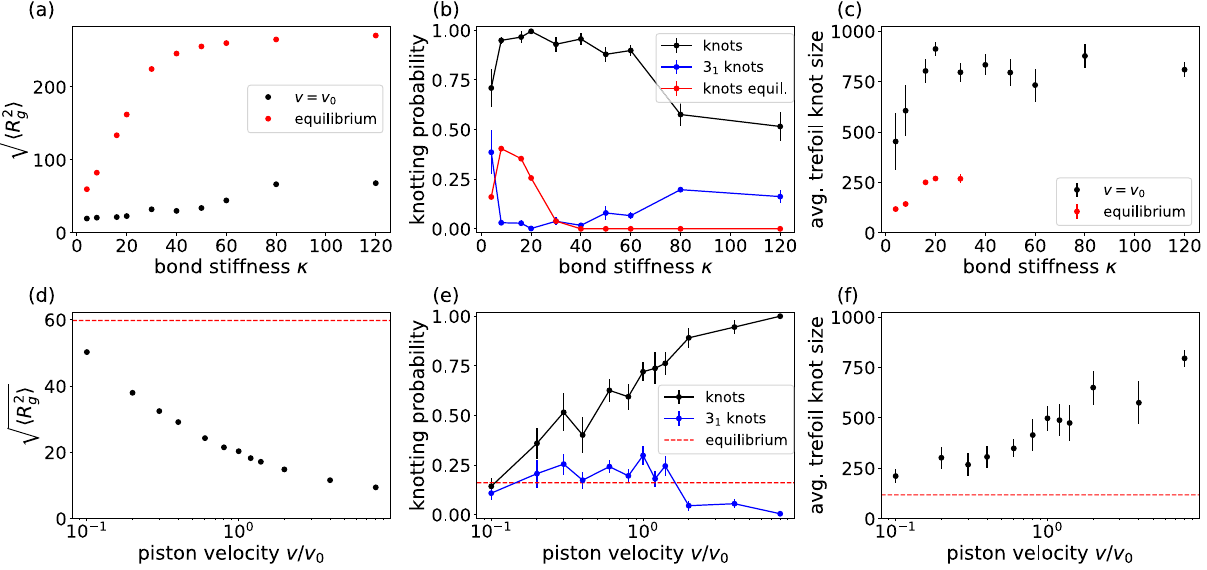
Figure 1. Knots and radii of gyration of steady-state configurations for different input parameters. ( a ) Root- mean-squared radius of gyration (cid:31) (cid:31) R 2 g ( t ) (cid:30) for chains of different stiffness. Error bars are omitted as their size is smaller than the size of the points. ( b ) Knotting probability and occurrence probability of trefoil knots for different values of the bond stiffness κ . Error bars are determined by taking the standard deviation over the square-root of the number of runs. Lines are added for readability. Knotting probability for v = 0 is strictly zero for κ ≥ 50 . ( c ) Trefoil knot lengths found for different κ with a moving piston and in equilibrium. ( d ) (cid:31) (cid:31) R 2 g ( t ) (cid:30) for different piston velocities at κ = 4 . Again the size of error bars would be smaller than the size of the points. The red dashes in ( d – f ) indicate the average result in MC simulations without a moving piston for κ = 4 which is equivalent to the leftmost equilibrium values in plots ( a – c ). ( e ) Knotting probabilities for different piston velocities at κ = 4 . ( f ) Trefoil knot lengths for different piston velocities at κ = 4